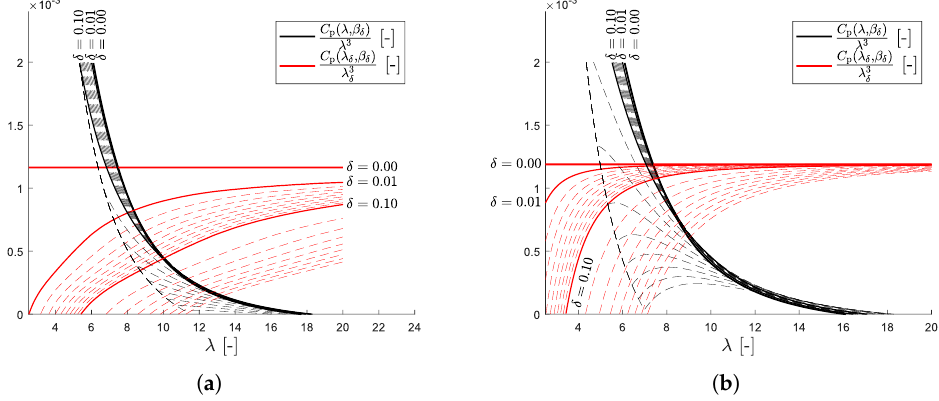
Figure 14. Constant delta control stability criterion for NREL 5-MW ( a ) and DTU 10-MW ( b ) reference turbines, with variable generator speed and